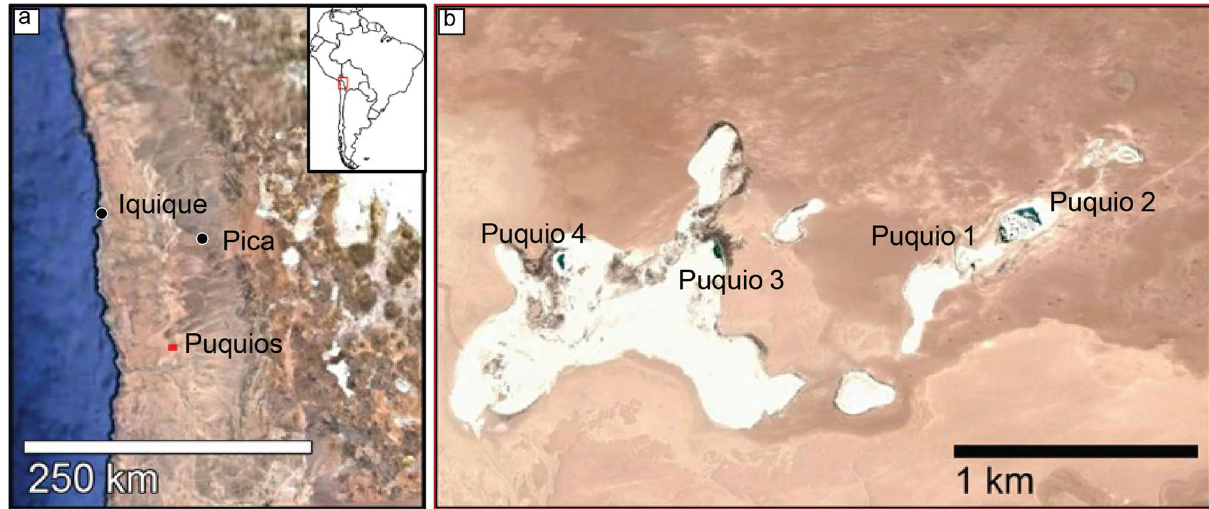
Figure 1. Location map—( a ) regional context and location of the Puquios within northern Chile; ( b ) enlarged view of the red square in ( a ) showing the location of the Puquios within the Salar de Llamara. Imagery from ArcGIS World Imagery basemap; sources: Sources: Esri, DigitalGlobe, GeoEye, i-cubed, USDA FSA, USGS, AEX, Getmapping, Aerogrid, IGN, IGP, swisstopo, and the GIS User Community. Figure was created in Microsoft PowerPoint for Mac v16.48 https:// www. micro soft. com/ en- us/ micro soft- 365/ power